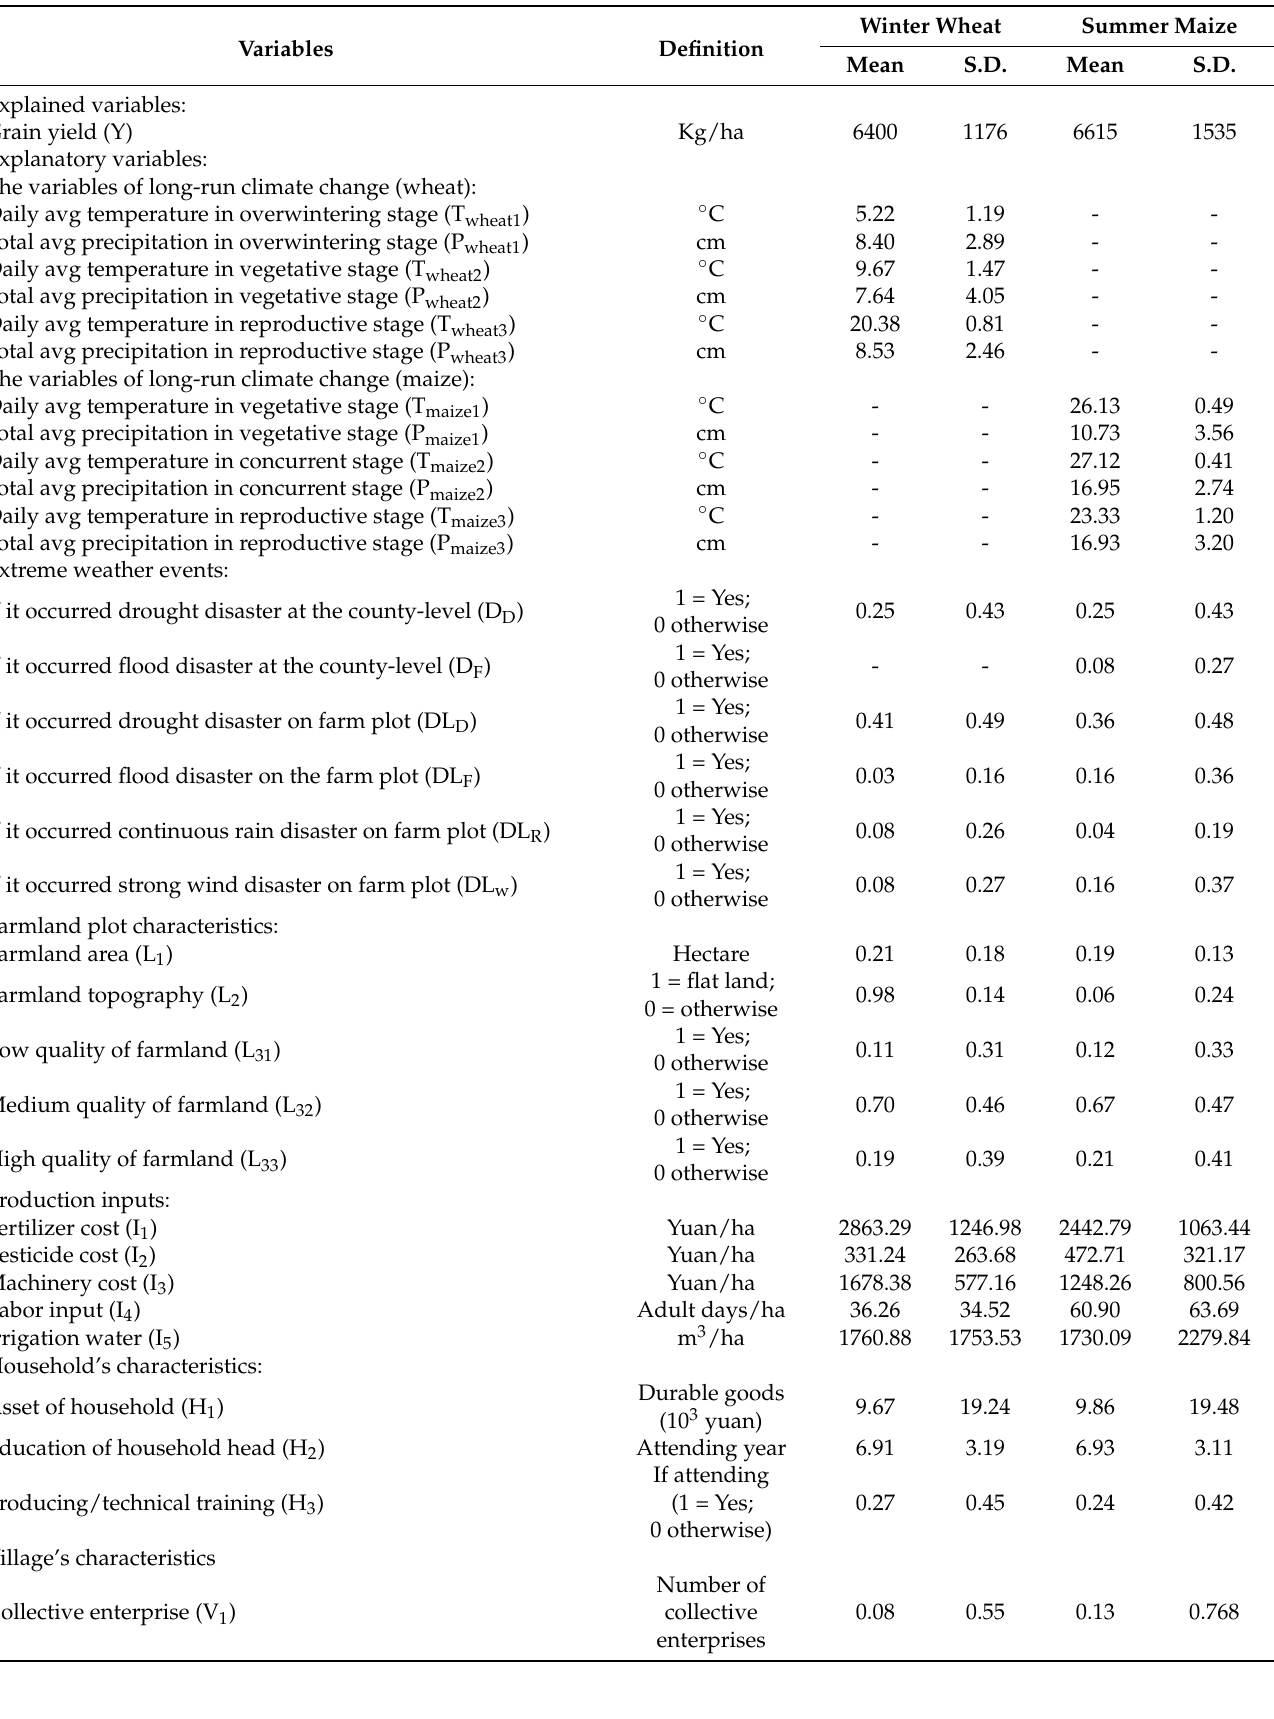
Table 4. Summary statistics of variables